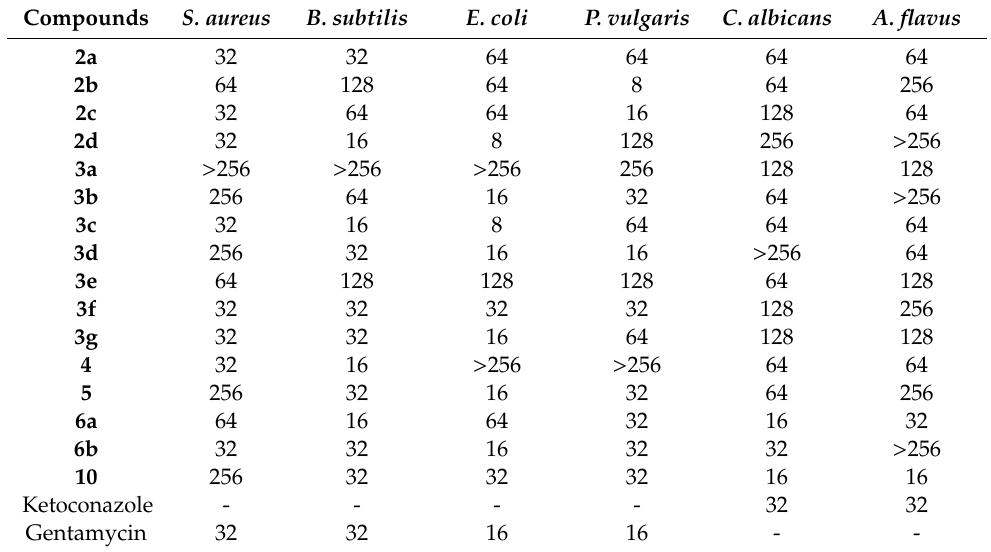
Table 2. The minimal inhibitory concentration (MIC: µ g / mL) of the tested compounds. Compounds S. aureus B. subtilis